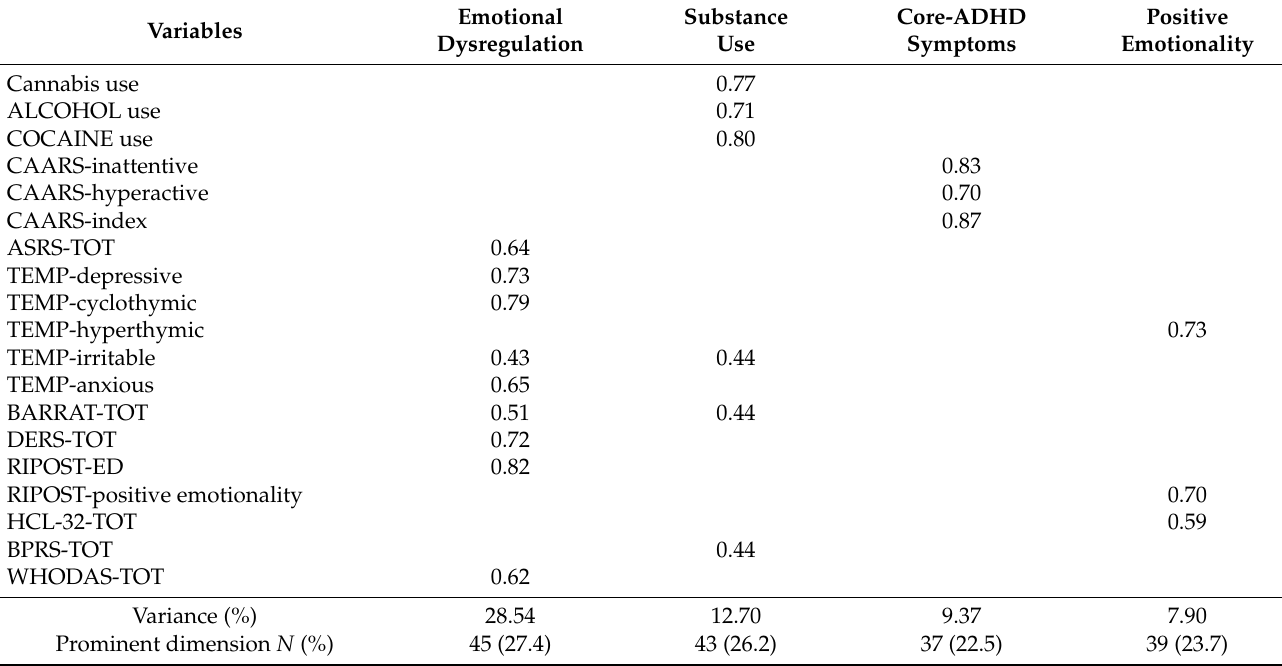
Table 1. Factor structure of Emotional Dysregulation, Substance Use, Core-ADHD Symptoms and Positive Emotionality dimensions. N = 164.